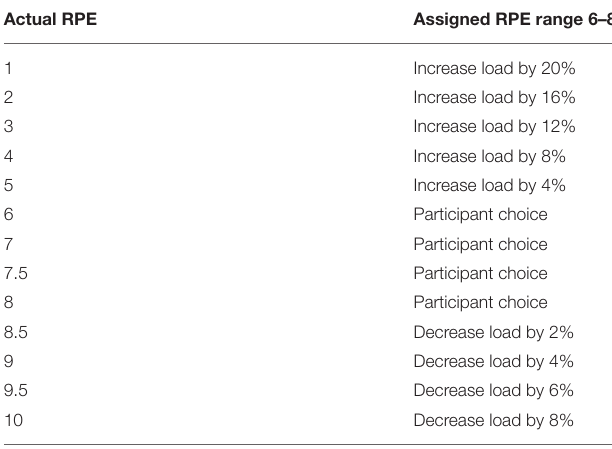
TABLE 3 | Example RPE load